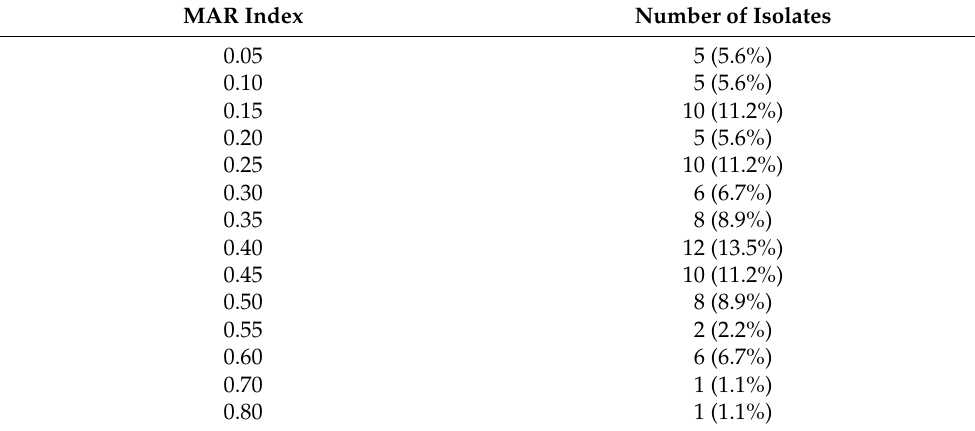
Table 2. Multiple antibiotic resistance index (MARI) of CoNS isolates.